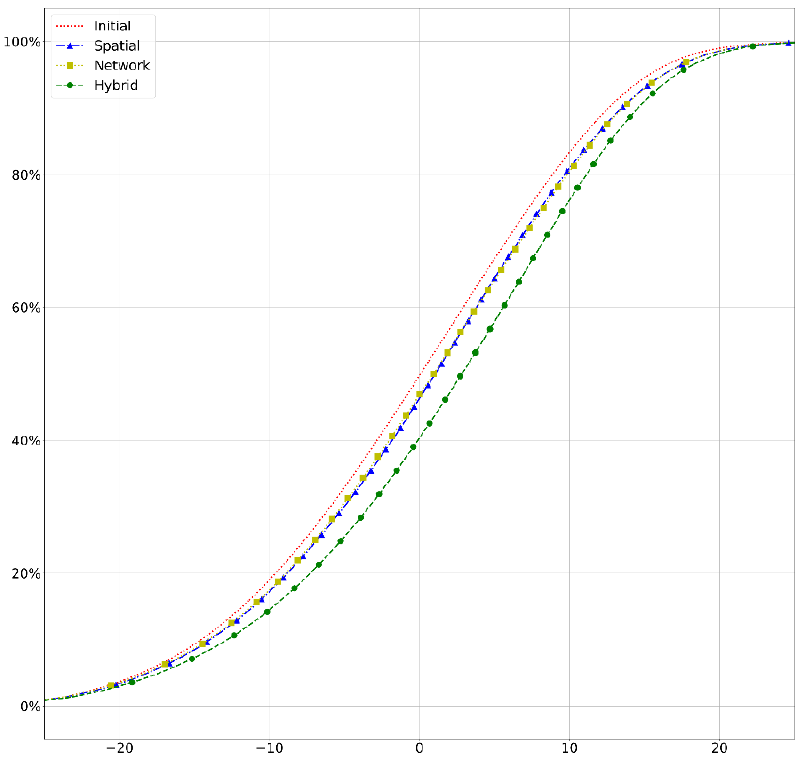
Figure 8. Performance evaluation of each algorithm vs. the initial scenario for SINR (dB) CDF.